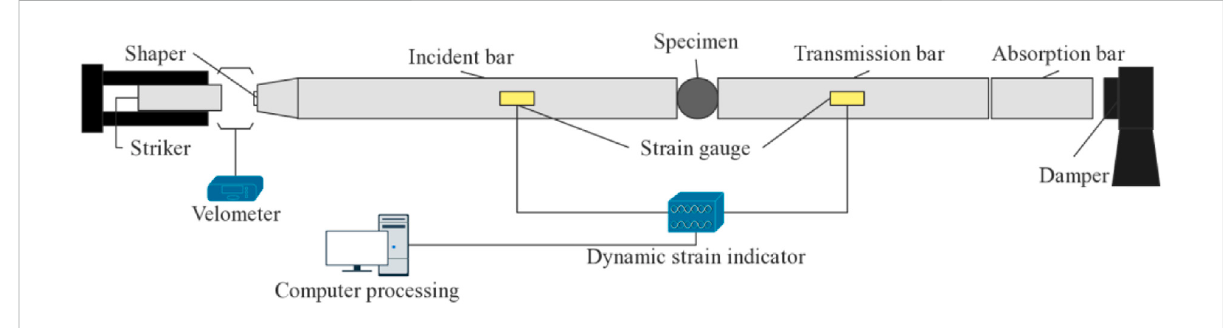
FIGURE 2 Schematic of the SHPB impact test